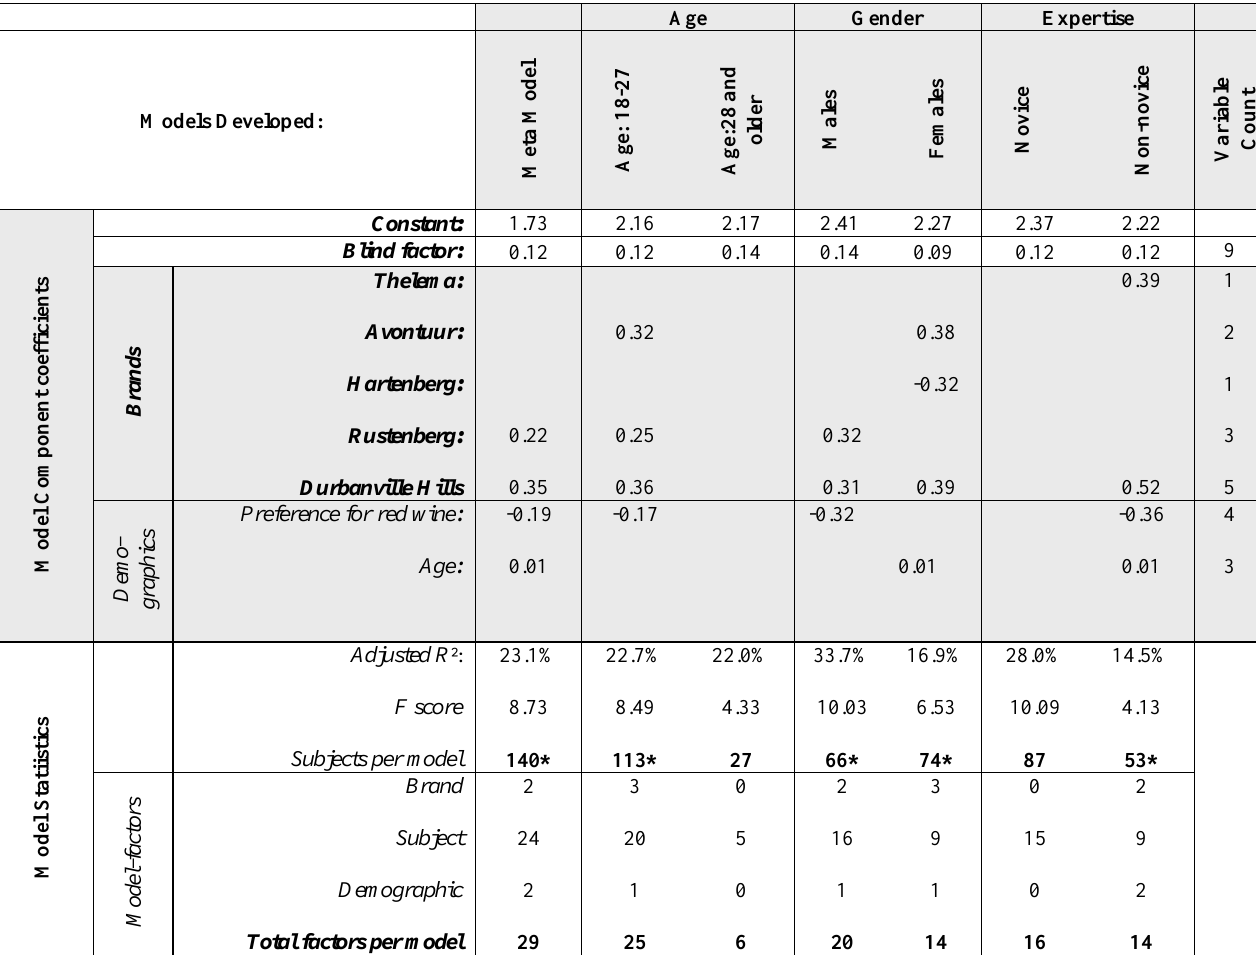
Summation table of brand effects identified across the demographic models computed prior to the mediation analysis. (*: Note: subject-data extracted for this paper’s analysis sum to 446 respondents